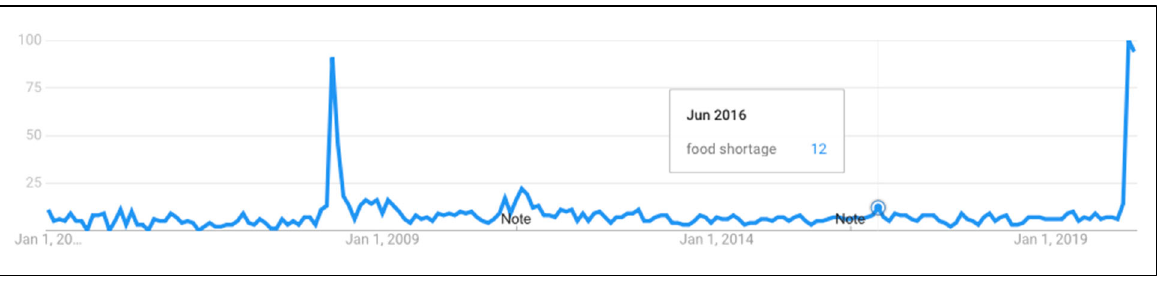
Source: Google Trends, April 27, 2020; the geography of search is the U.S.; The “note” labels mark when Google Trends made a change in the collection method.